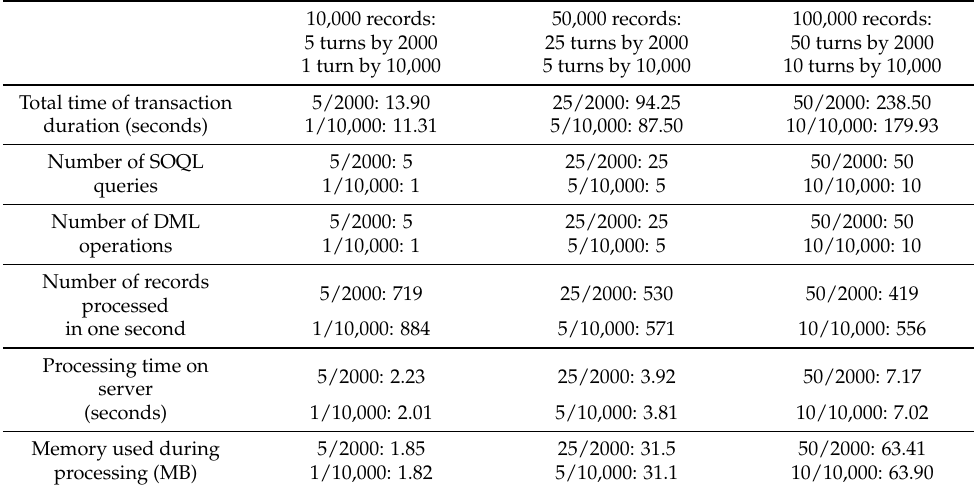
Table 8. Apex Queueable processing results for delete operation.